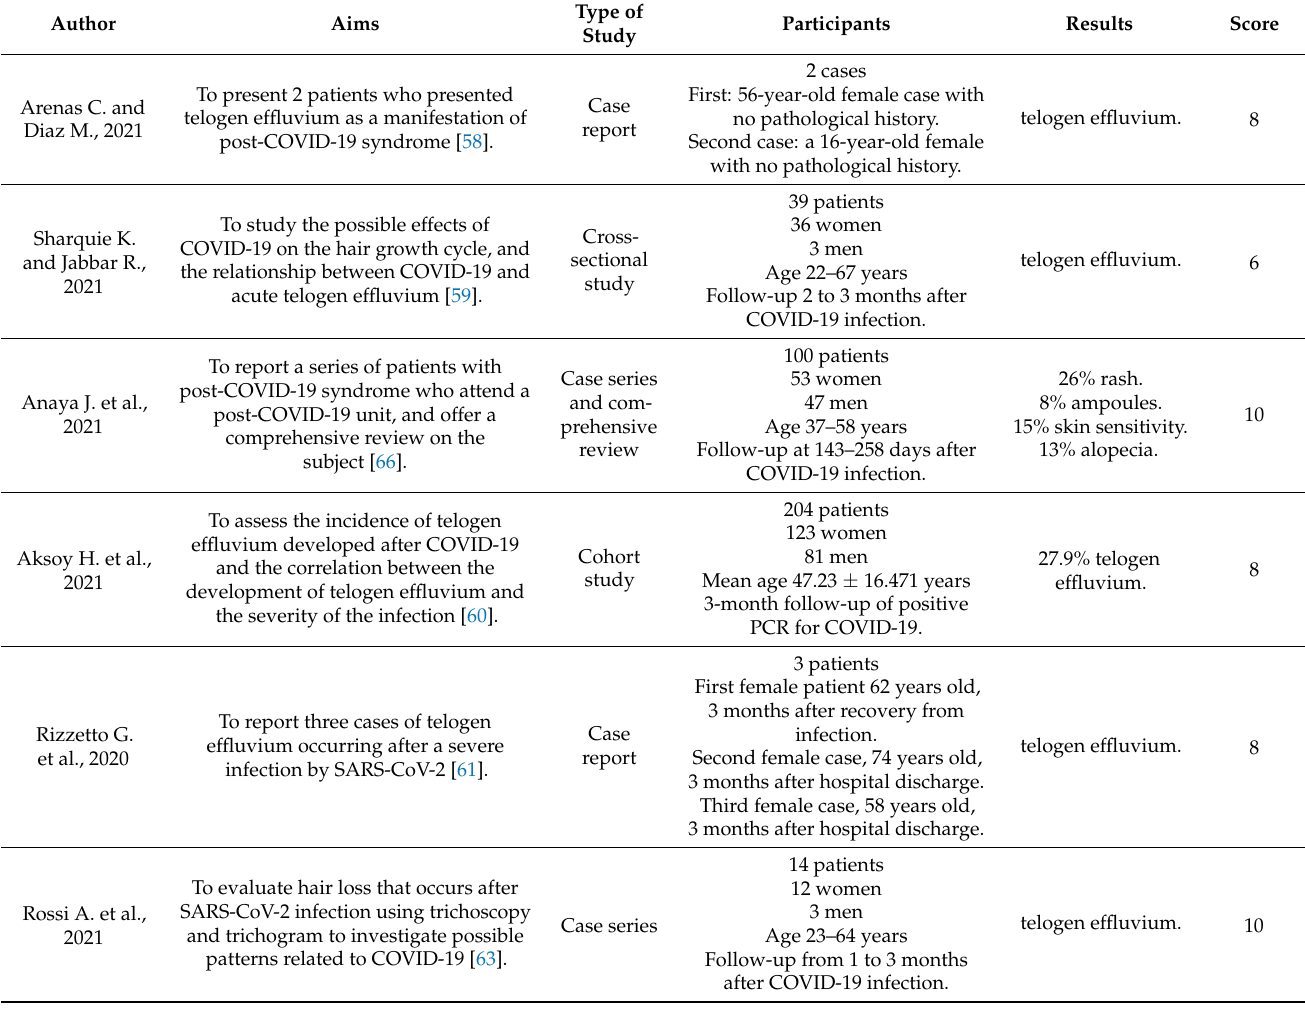
Table 5. Summary of literature mentioning skin sequelae.